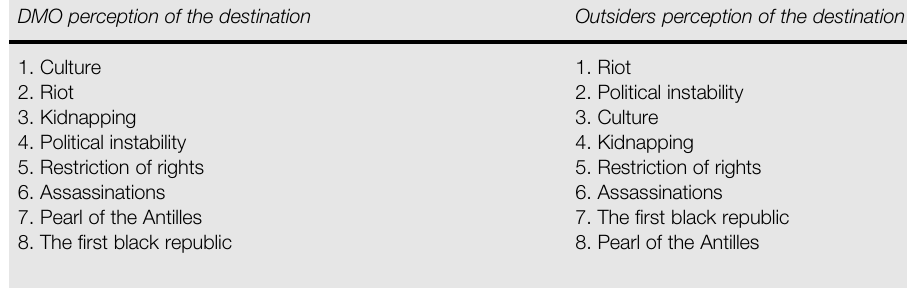
Table III Factors impacting on the perception of the